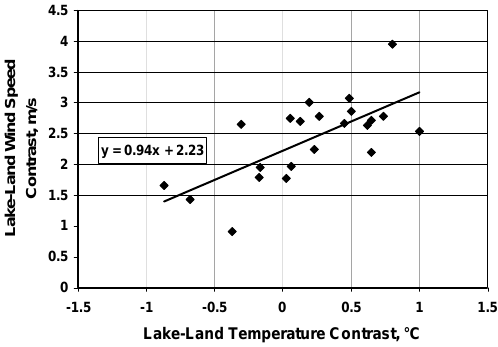
Fig. 3. The observed relationship between the 5-day average lake- Figure 3. The observed relationship between the 5-day average lake-land wind speed contrast land wind speed contrast and the lake-land temperature contrast, for and the lake-land temperature contrast, for Crean Lake, 2006. Crean Lake,